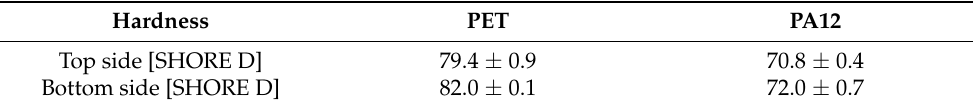
Table 3. Comparison of hardness SHORE D of tensile specimens manufactured from PET and PA12 in HSS. Hardness PET PA12 Top side [SHORE D] Bottom side [SHORE